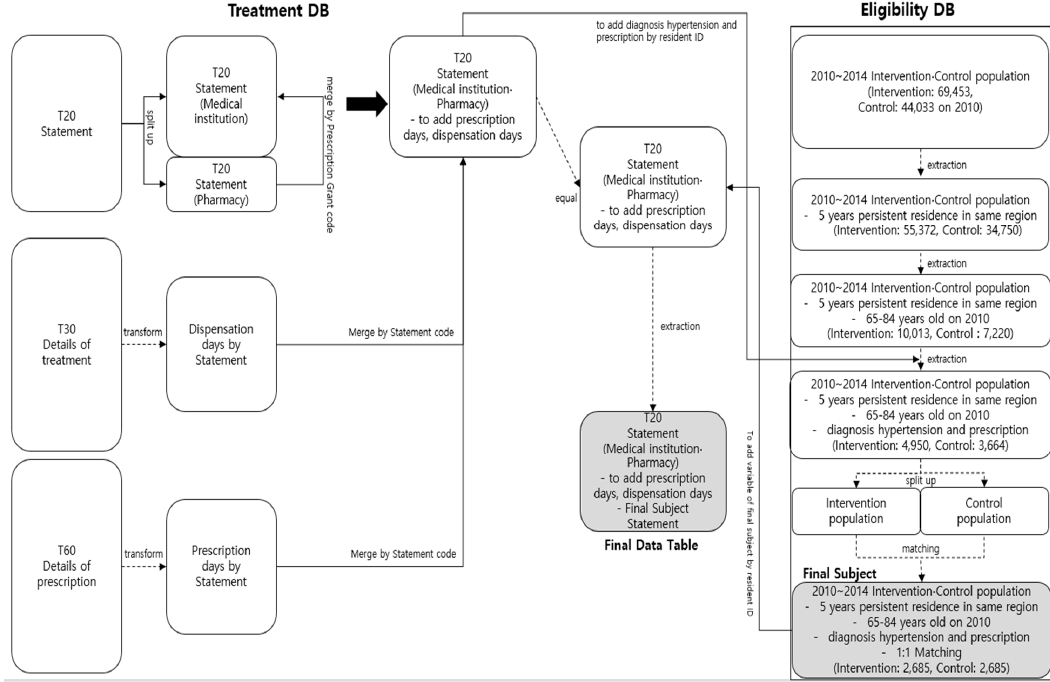
Figure 1. Flowchart for selecting study subjects using the Korean National Health Insurance (KNHI) Big Data on the community-based intervention program.